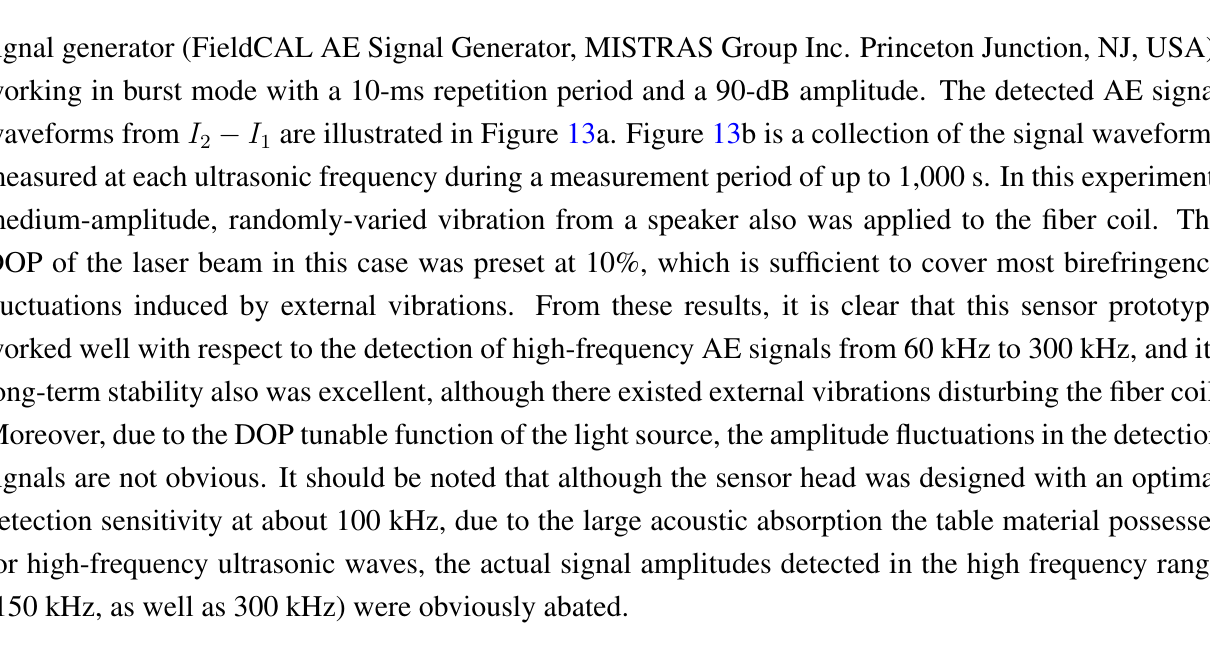
Measured signal waveforms used for investigating: ( a ) frequency response; ( b ) long-term